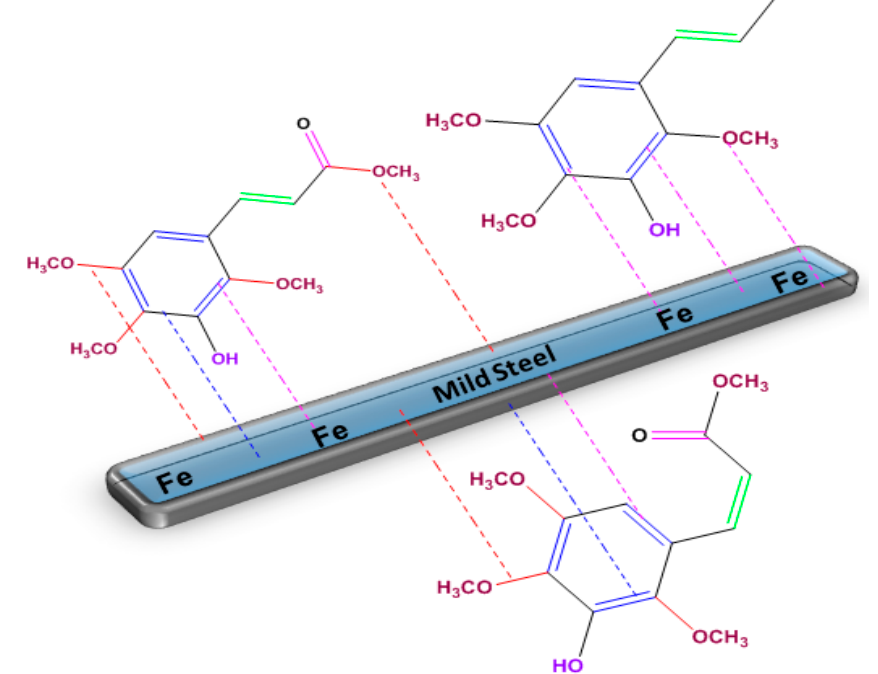
Figure 8. An illustration of possible corrosion mechanism of C. tagal extract.